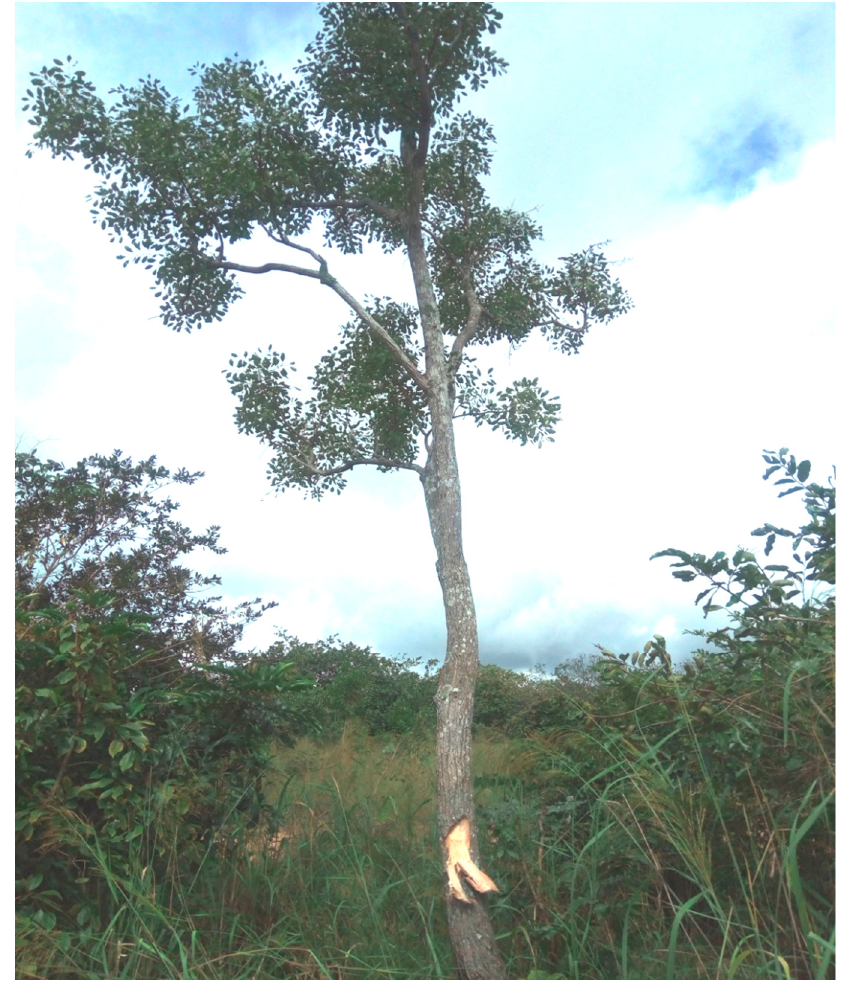
Figure 1. Lannea barteri tree growing in Nigeria used in sample collection.